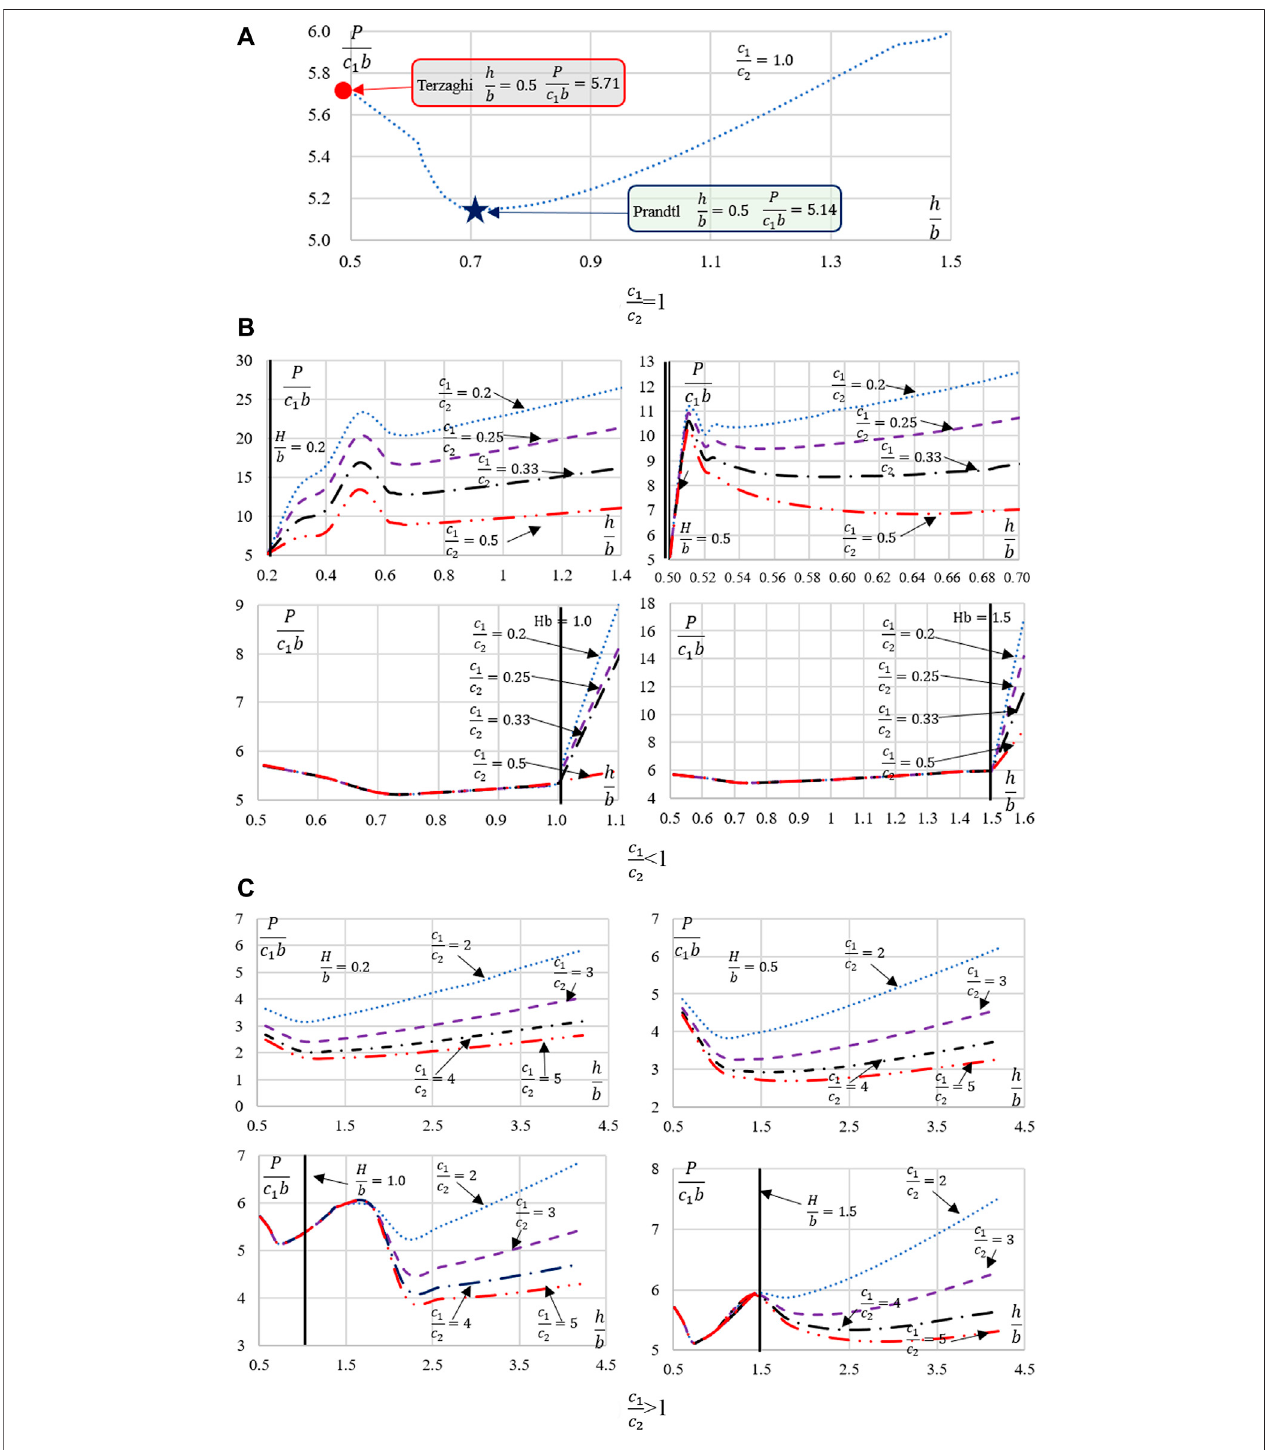
− P . Curve. (A) c 1 b c 1 b